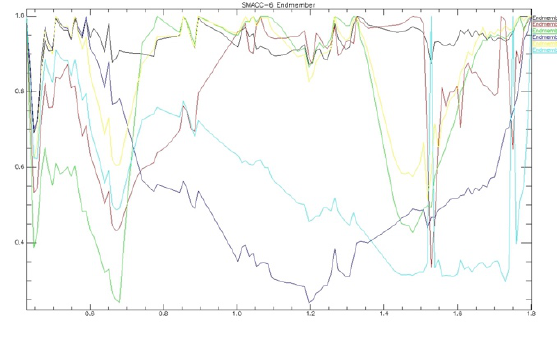
Fig. 8. Endmember extraction results.